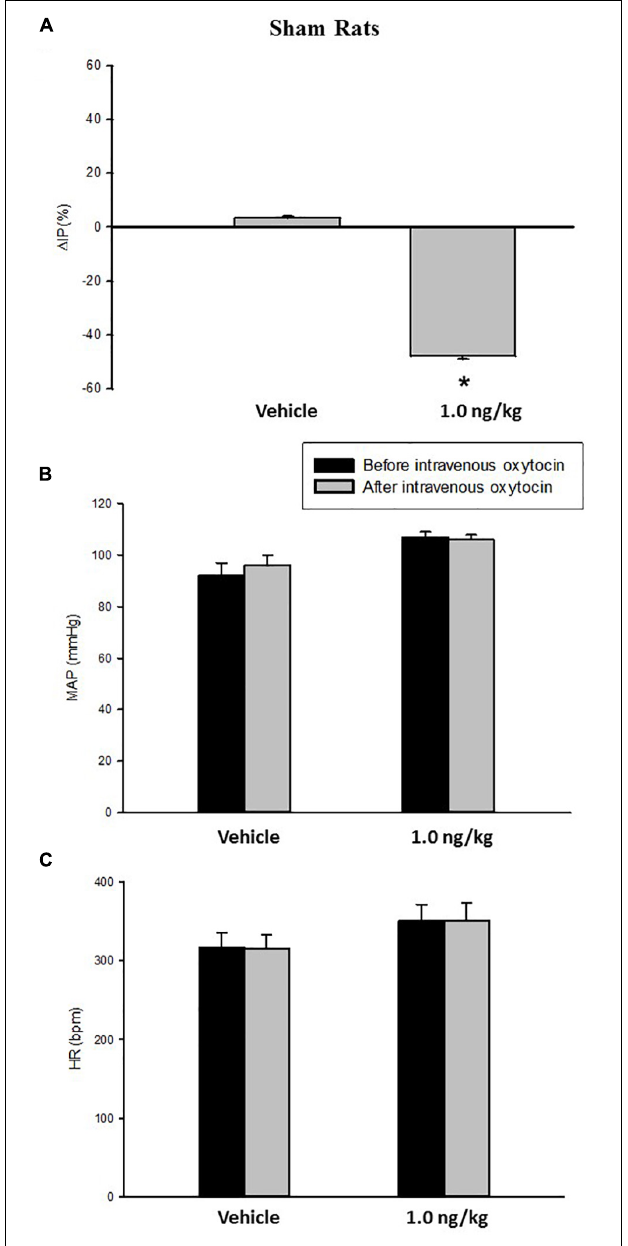
FIGURE 1 | Percent change in intravesical pressure ( A , % (cid:49) IP) after intravenous injection of saline (vehicle) or oxytocin dose (1.0 ng/kg of b.w.) in sham animals. Mean arterial pressure ( B , MAP, mmHg) and heart rate ( C , HR, bpm) at baseline and after intravenous injection of saline (vehicle) or oxytocin dose (1.0 ng/kg of b.w.) in sham animals, * p < 0.05 vs. saline ( N =